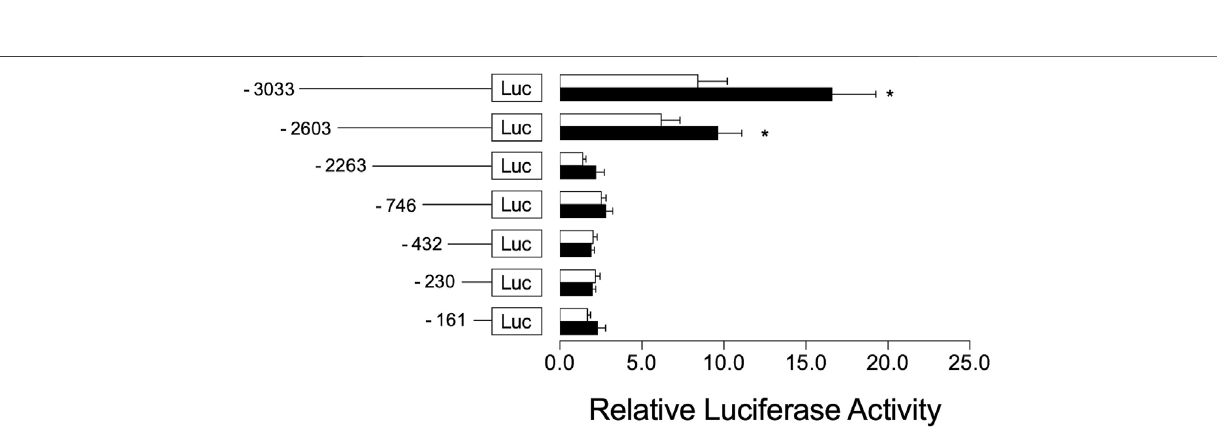
FIGURE 8 | CAR co-transfection increases Cyp2a5 transcriptional activation. Mouse Cyp2a5 promoter reporter assays were conducted in primary mouse hepatocytes transfected with progressively truncated luciferase reporter constructs (white bars) and co-transfected with a CAR expression plasmid (black bars). Luciferase activities were measured 24 h after transfection. The measured activities were normalized against Renilla (pR-TK) activities. All values represent the mean ± SEM derived from n (cid:2) 3 hepatocyte cultures from different mice. The effect of CAR on each reporter construct is indicated by fold activity relative to control hepatocytes co-transfected with pcDNA3.1. Mean difference is signi fi cant from the control group at * p ≤